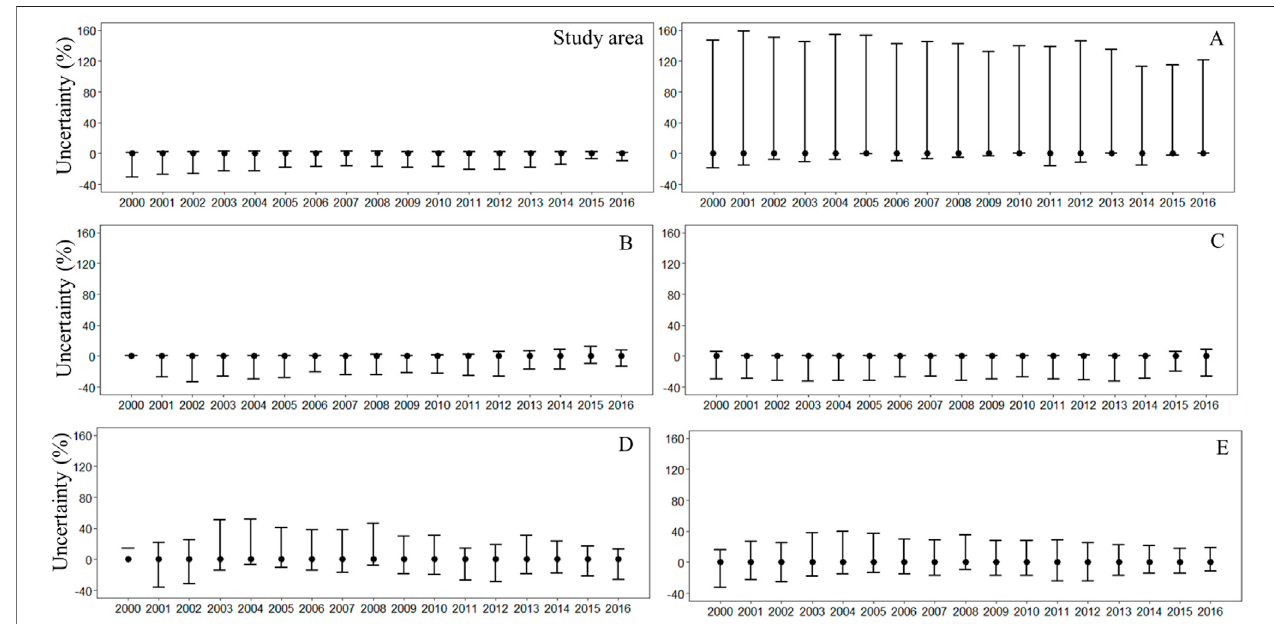
FIGURE 12 | Uncertainty of annual premature deaths in different areas. Areas with signi fi cant differences both in PM2.5 concentration and premature deaths.